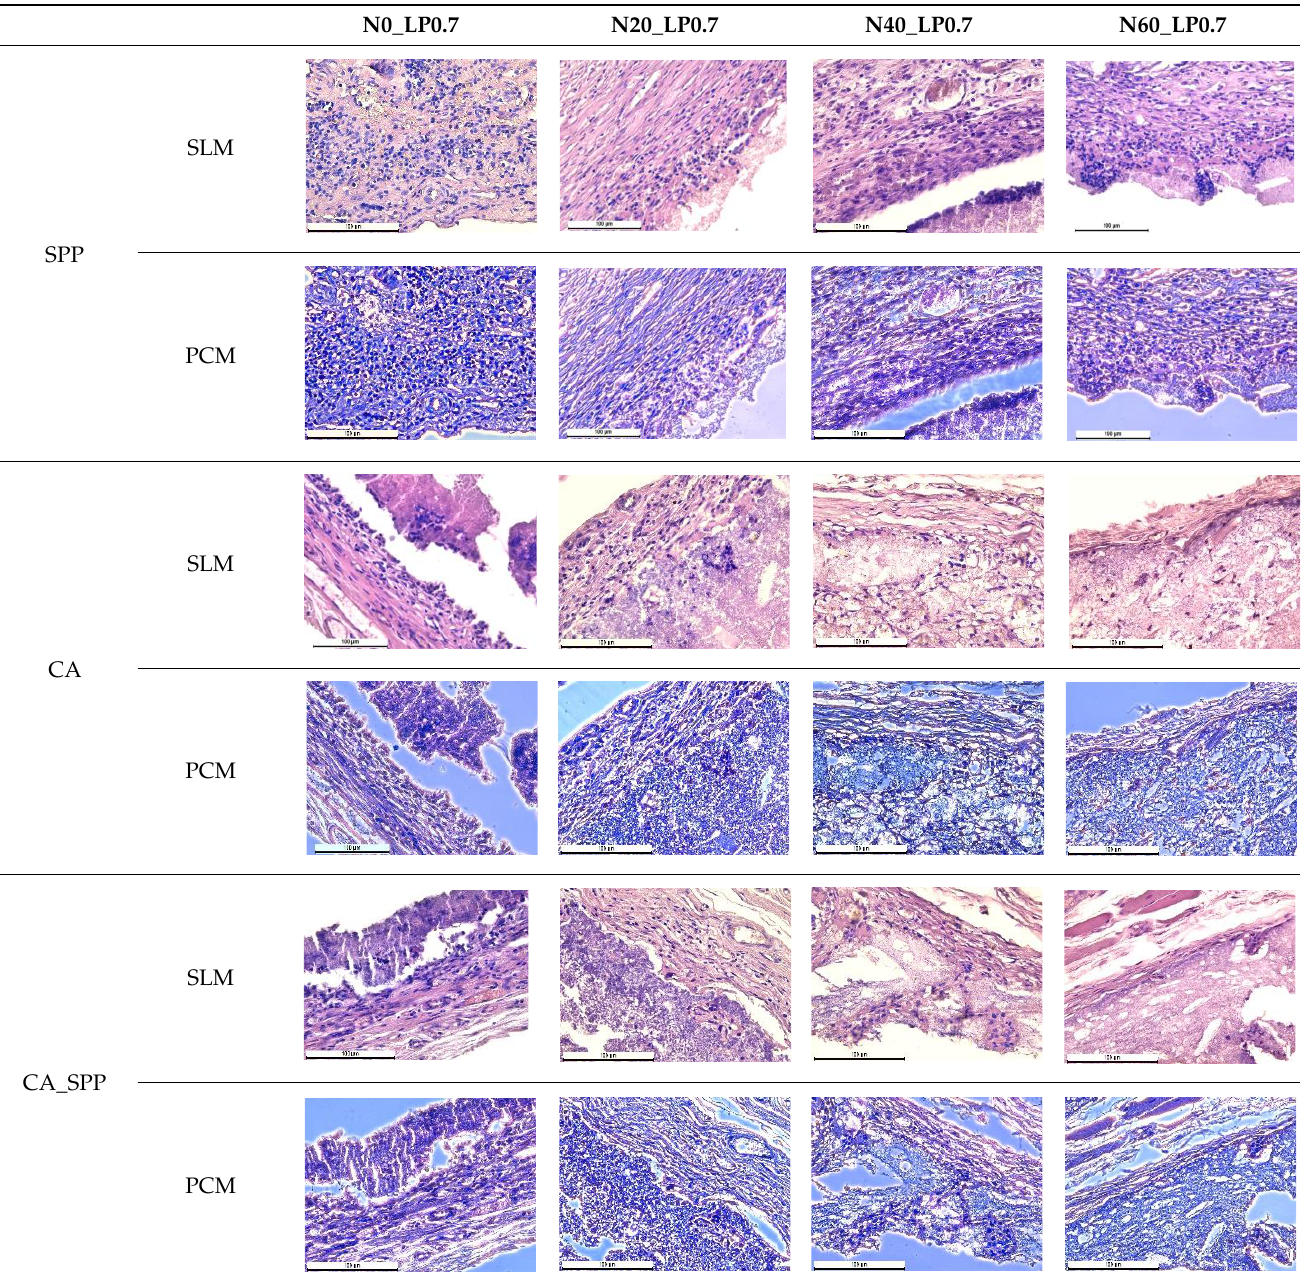
Table 8. Section photos for the studied samples at different microscopy modes.